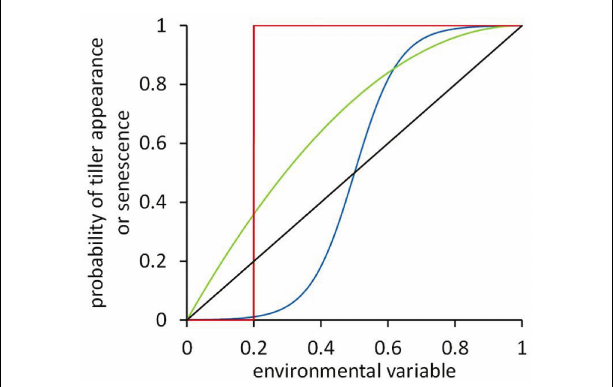
FIGURE 2 | Dose–response curves representing the response of tiller appearance or senescence probability to some environmental variable. Four hypothetical curves are shown: unit-step response with a threshold value of 0.2 (red line), a curvilinear response (green line), a sigmoidal response with an inflection point at 0.5 (blue line), and a linear response (black